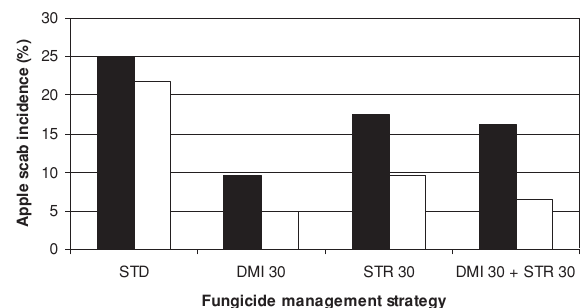
Figure 2. Effi cacy of DMI and strobilurin spray programmes (STD = Standard, DMI 30 = DMI dominant, STR 30 = strobilurin dominant, DMI 30 + STR 30 = DMI and strobilurin dominant) on apple scab incidence on leaves (black coloumn) and fruits (white coloumn) of cultivar Jonagold in 2010 at Ófehértó (LSD = 5.1 – leaf; LSD = 4.2 – fruit). 0.05 0.05